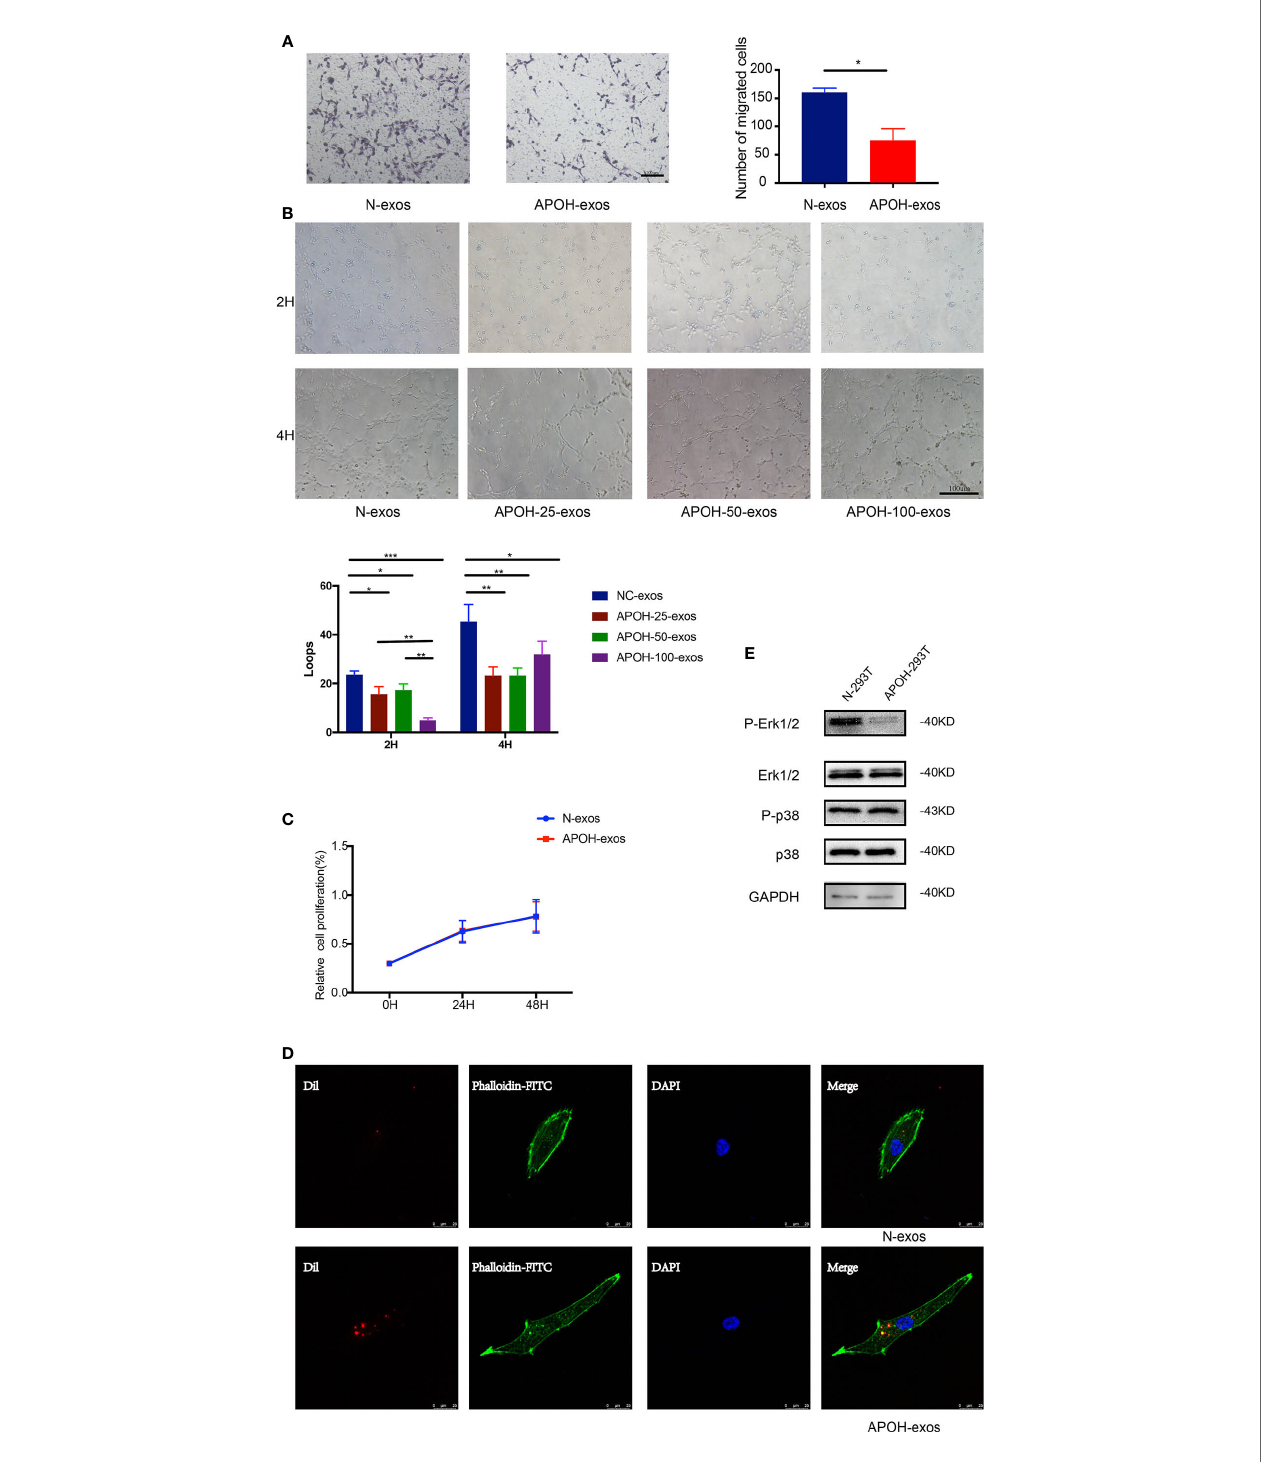
FIGURE 6 | (A) After incubation with 25 m g/ml APOH-exosome (exos) or 25 m g/ml control (N)-exos for 16 h, human umbilical vein endothelial cell (HUVEC) migration was analyzed. Mean ± SD (*P = 0.014 by Paired t test). (B) After incubation with N-exos (50 m g/ml) or APOH-exos (25 m g/ml, 50 m g/ml, 100 m g/ml) for 2 h and 4 h, HUVEC angiogenesis was analyzed. Mean ± SD (*P < 0.05; **P < 0.01; ***P < 0.001 by t test). (C) After incubation with APOH-exos/N-exos (25 m g/ml) for 24h and 48h, HUVEC proliferation was analyzed by the cell counting kit-8 assay. Mean ± SD (*P = 0.183 by Paired t test). (D) The binding and endocytosis of APOH-exos/N- exos in HUVECs was observed by laser scanning confocal microscopy. (E) After 16 h of incubation of HUVECs with APOH-exos, the levels of Erk 1/2, P-Erk 1/2, p38 and P-p38 were determined by western